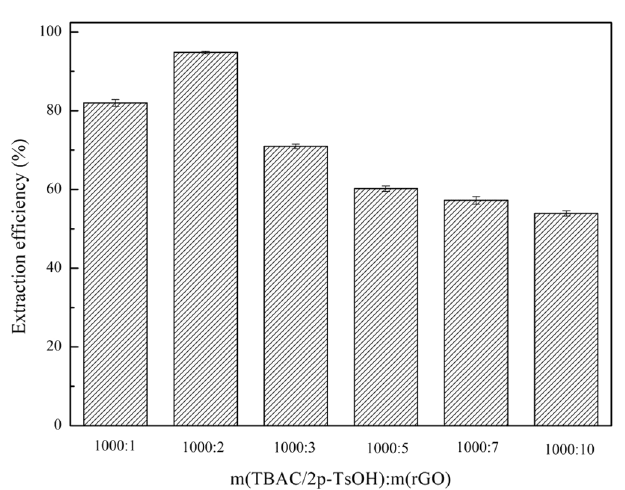
Figure 5. The effect of different loading amounts of TBAC/2p-TsOH on the extraction efficiency (experimental conditions: 1.2 g (TBAC/2p-TsOH)/rGO, 0.5 g simulated oil (1600 mg/L sulphur content), 0.25 g H 2 O 2 , 25 °C, 800 rpm, 60